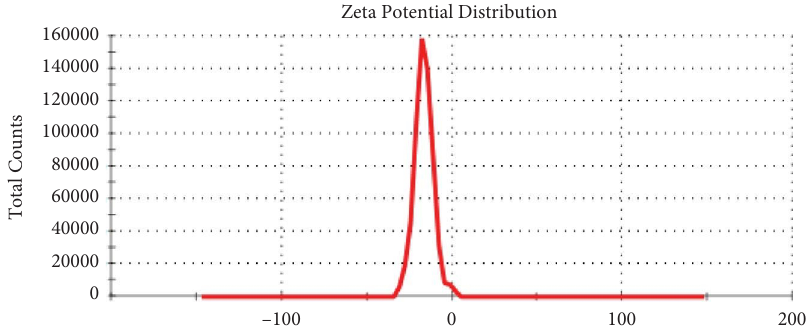
Figure 4: Zeta potential analysis of biosynthesized ZnO